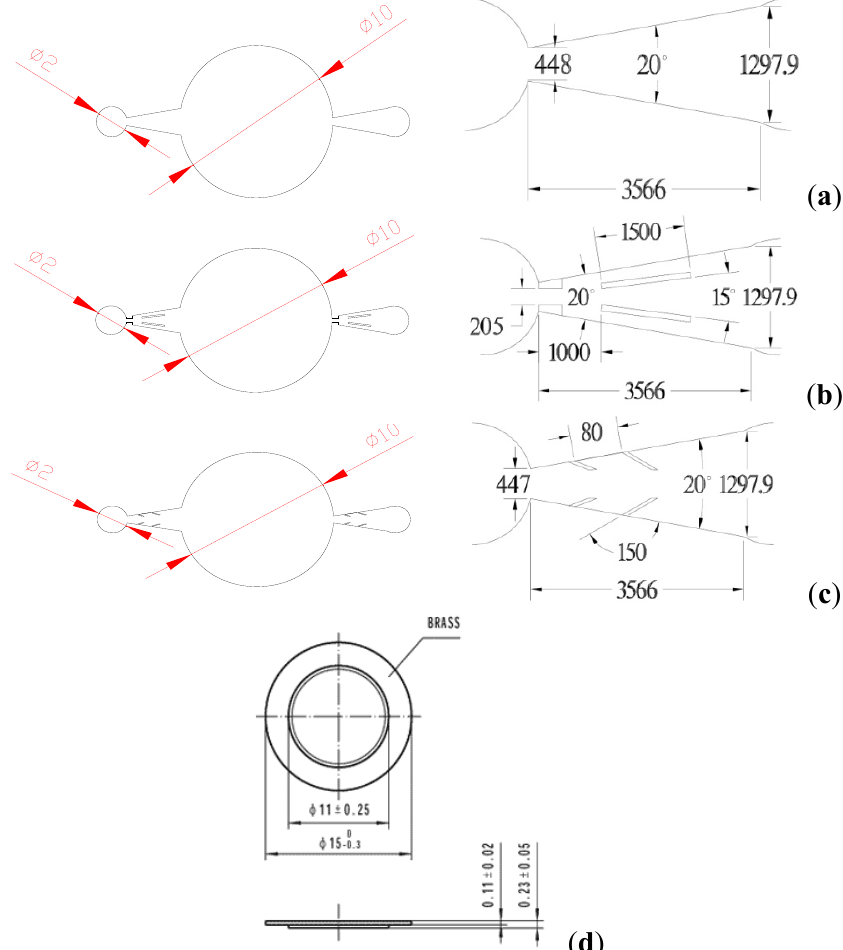
Figure 5. Detailed geometry of the test micro nozzle/diffuser and piezoelectric